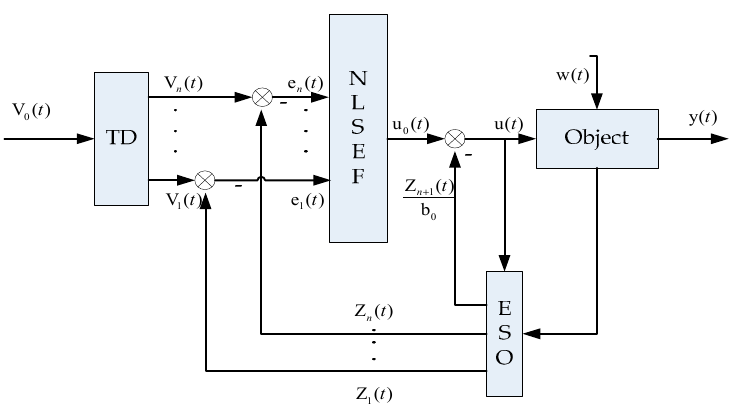
Figure 5. Structural block diagram of the active disturbance rejection control (ADRC) algorithm.